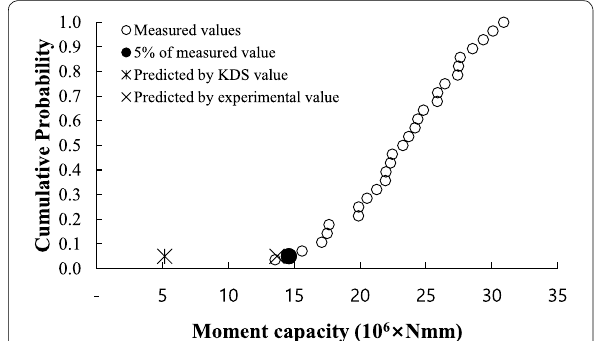
Fig. 6 Comparisons of measured and predicted moment capacity of